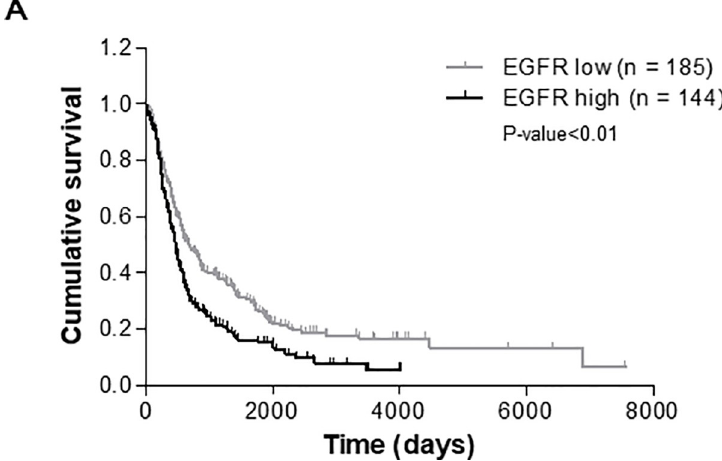
Fig 1. Kaplan-Meier plot of survival curve for all glioma patients according to EGFR expression. (A) These data are based on the log-rank test (P-value < 0.01). Data were obtained from the Repository for Molecular Brain Neoplasia Data (REMBRANDT) program of the National Cancer Institute.